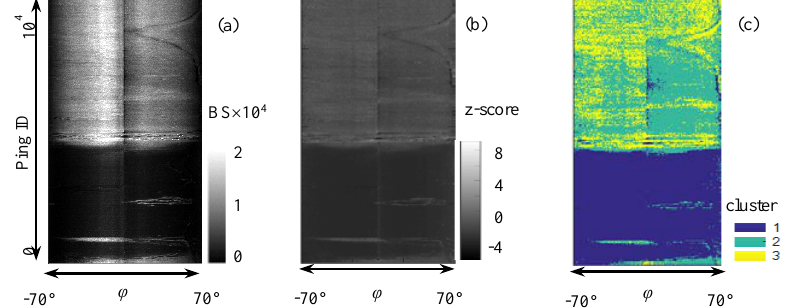
Figure 8. Raw SSS image ( a ); normalized z-score image ( b ); and the classified image ( c ). φ denotes the incident angle.